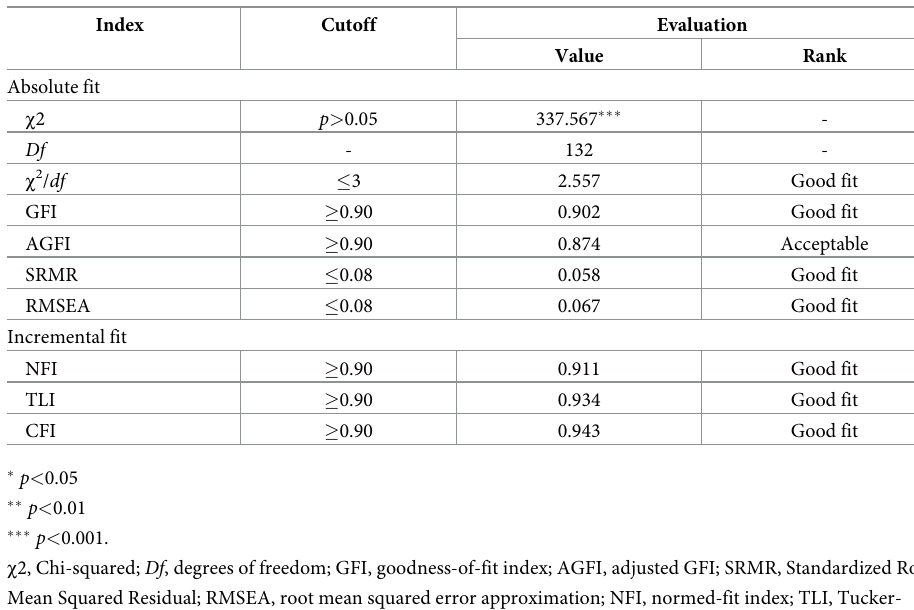
Table 5. The model